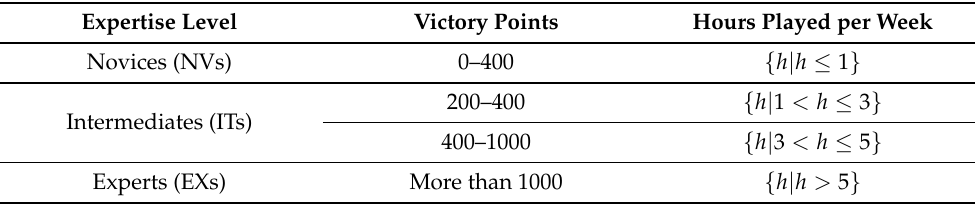
victory points, and the number of hours spent per week playing the game League of Legends .